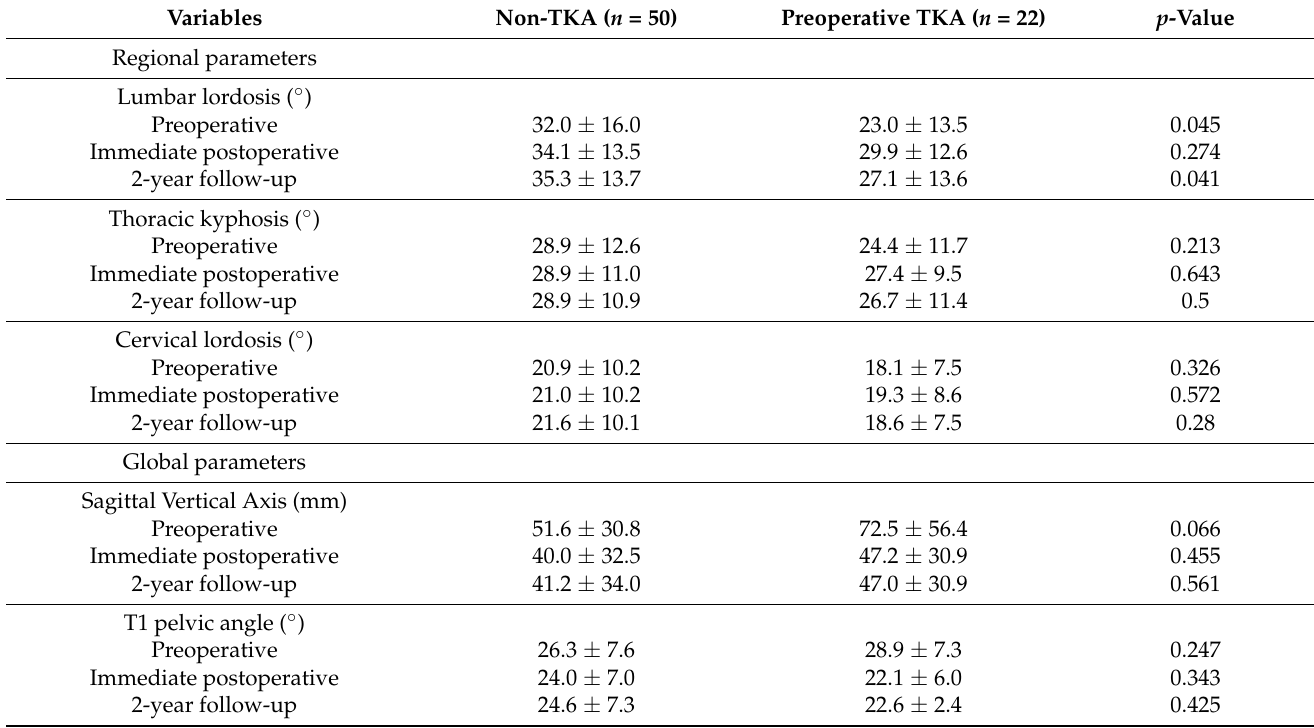
Table 2. Comparison of regional and global parameters between spinal fusion only and preoperative TKA with spinal fusion